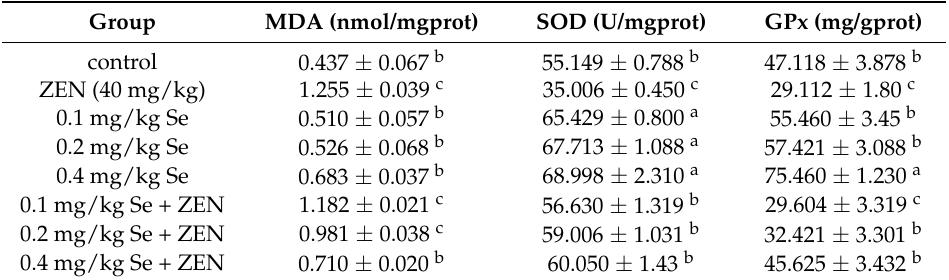
Table 4. Effect of Se on testis antioxidant parameters in mice induced by ZEN.